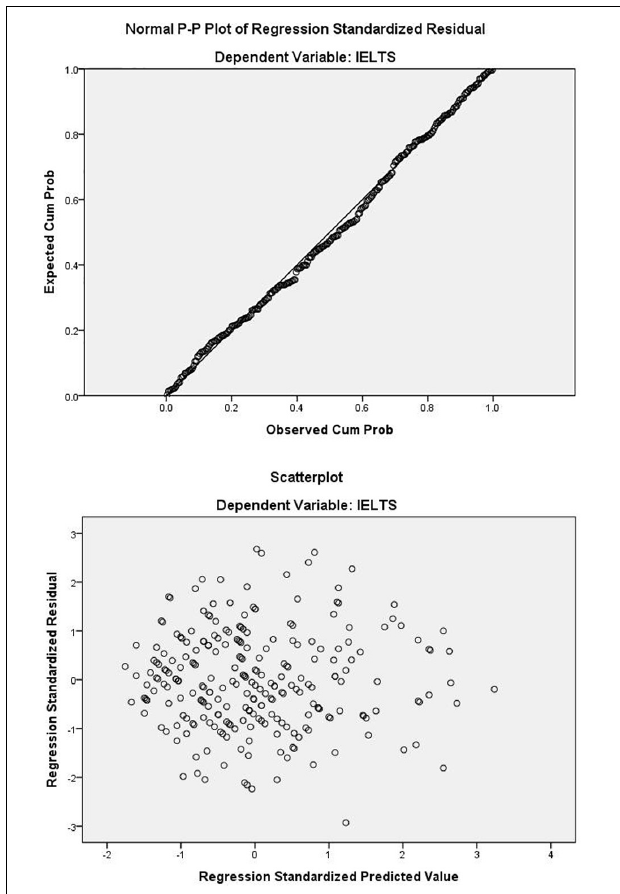
FIGURE 1 | Regression